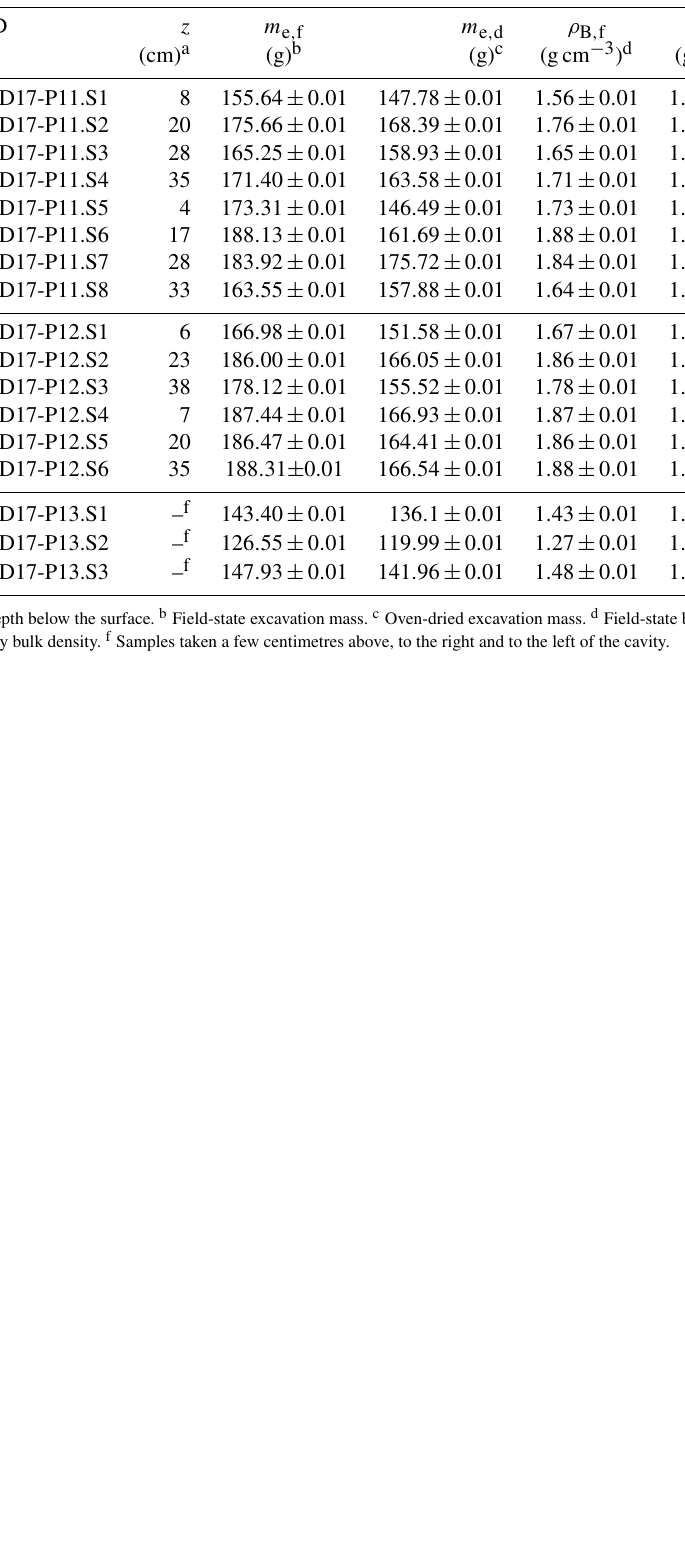
Table B3. Samples from sample rings taken at sites BD17-P11, BD17-P12 and